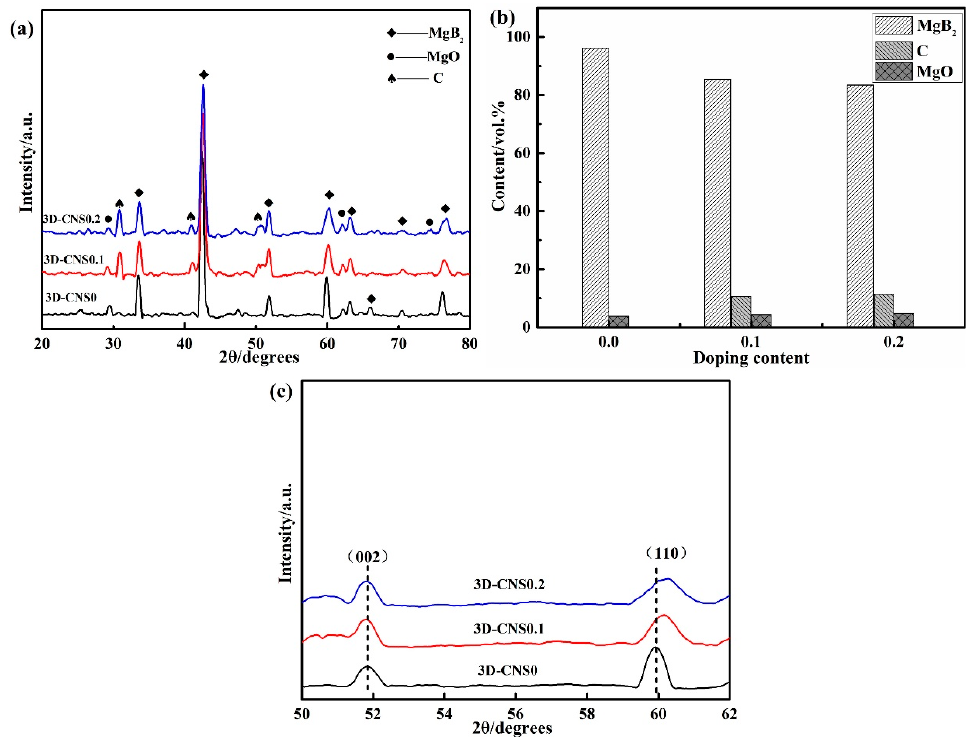
Figure 5. ( a ) XRD patterns ( b ) volume fraction of each phase and ( c ) local magnification of 3D-CNS doped samples. Table 2. Comparison of lattice parameters, carbon doping level, characteristic peak position and FWHM of doped 3D-CNS composite samples.